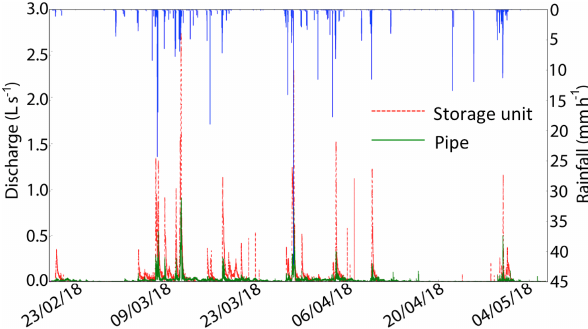
Figure 5. Rainfall and computed discharges for the whole time pe- riod.